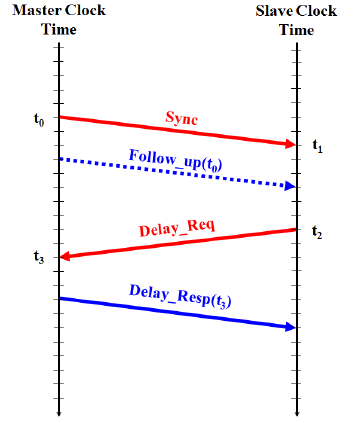
Figure 3. Delay request–response mechanism of the PTP timing exchange